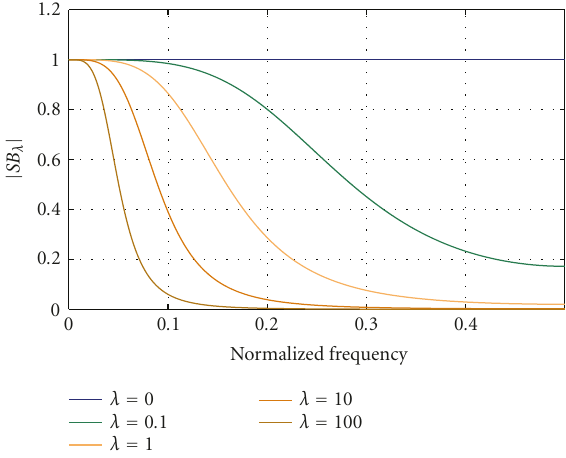
Figure 5: Frequency response of the smoothing-spline filter SB λ for di ff erent values of λ